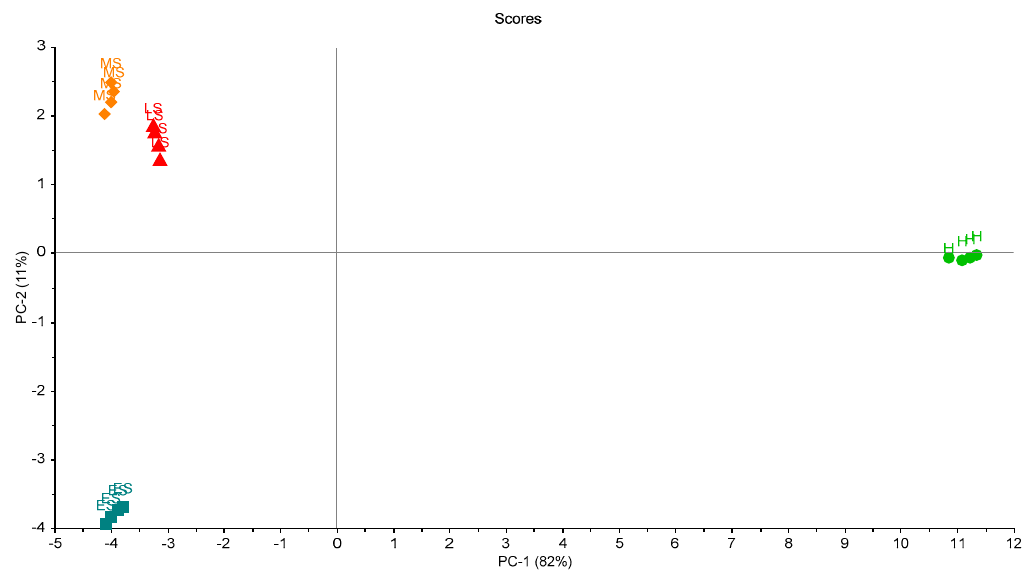
Figure 7. Scores plot of the samples in the first trial of measurements. A clear separation between grouped samples is presented. Healthy samples (H), infected early-stage (ES), infected-moderate- stage (MS), and infected late-stage (LS).